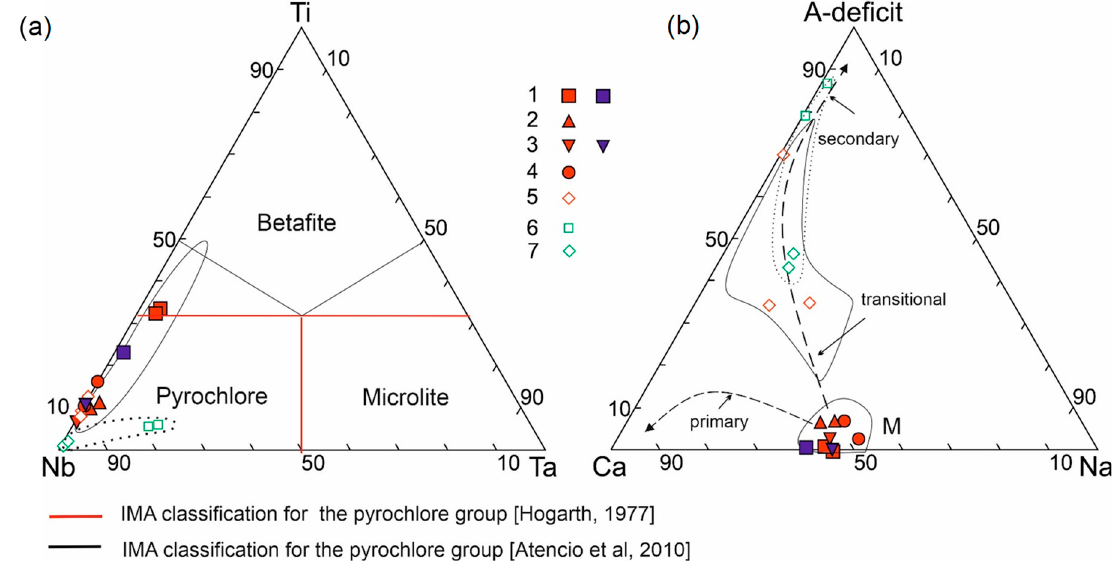
Figure 9. Pyrochlore compositions of the Urals and Timan carbonatite complexes: triangular diagrams reflecting the filling of B- and A-positions (p.f.u.) in the structure of pyrochlore in accordance with the IMA classifications [100,124]. 1–5—Ilmeno–Vishnevogorsk (red signs) and Buldym complexes (blue signs), S. Urals: 1— uranpyrochlore I (U–(Ta)-rich oxy- and hydroxylcalciopyrochlore), 2— pyrochlore II (Ta- с ontaining fluorocalciopyrochlore), 3— pyrochlore III (fluorocalciopyrochlore), 4— pyrochlore IV (REE–Sr-containing fluorocalciopyrochlore); 5— pyrochlore V (Sr-REE-Ba hydroxylcalciopyrochlore and hydropyrochlore); 6, 7—Chetlassky complex (green sign), M. Timan [82]: 6—uranhydropyrochlore, 7—Sr-Ba hydropyrochlore. Solid line shows the composition fields for pyrochlore of Urals carbonatite complexes, dotted line—for pyrochlore of Timan carbonatites. ( a ) diagram Nb–Ti–Ta, after [100,124]; ( b ) diagram Ca–A-deficit–Na, after [133,134]. Dashed lines show the primary trend of magmatic (M) pyrochlore and an increase in the number of vacancies (A-deficit, see Table 1) during transitional (hydrothermal) and secondary (supergene) alteration of pyrochlore.